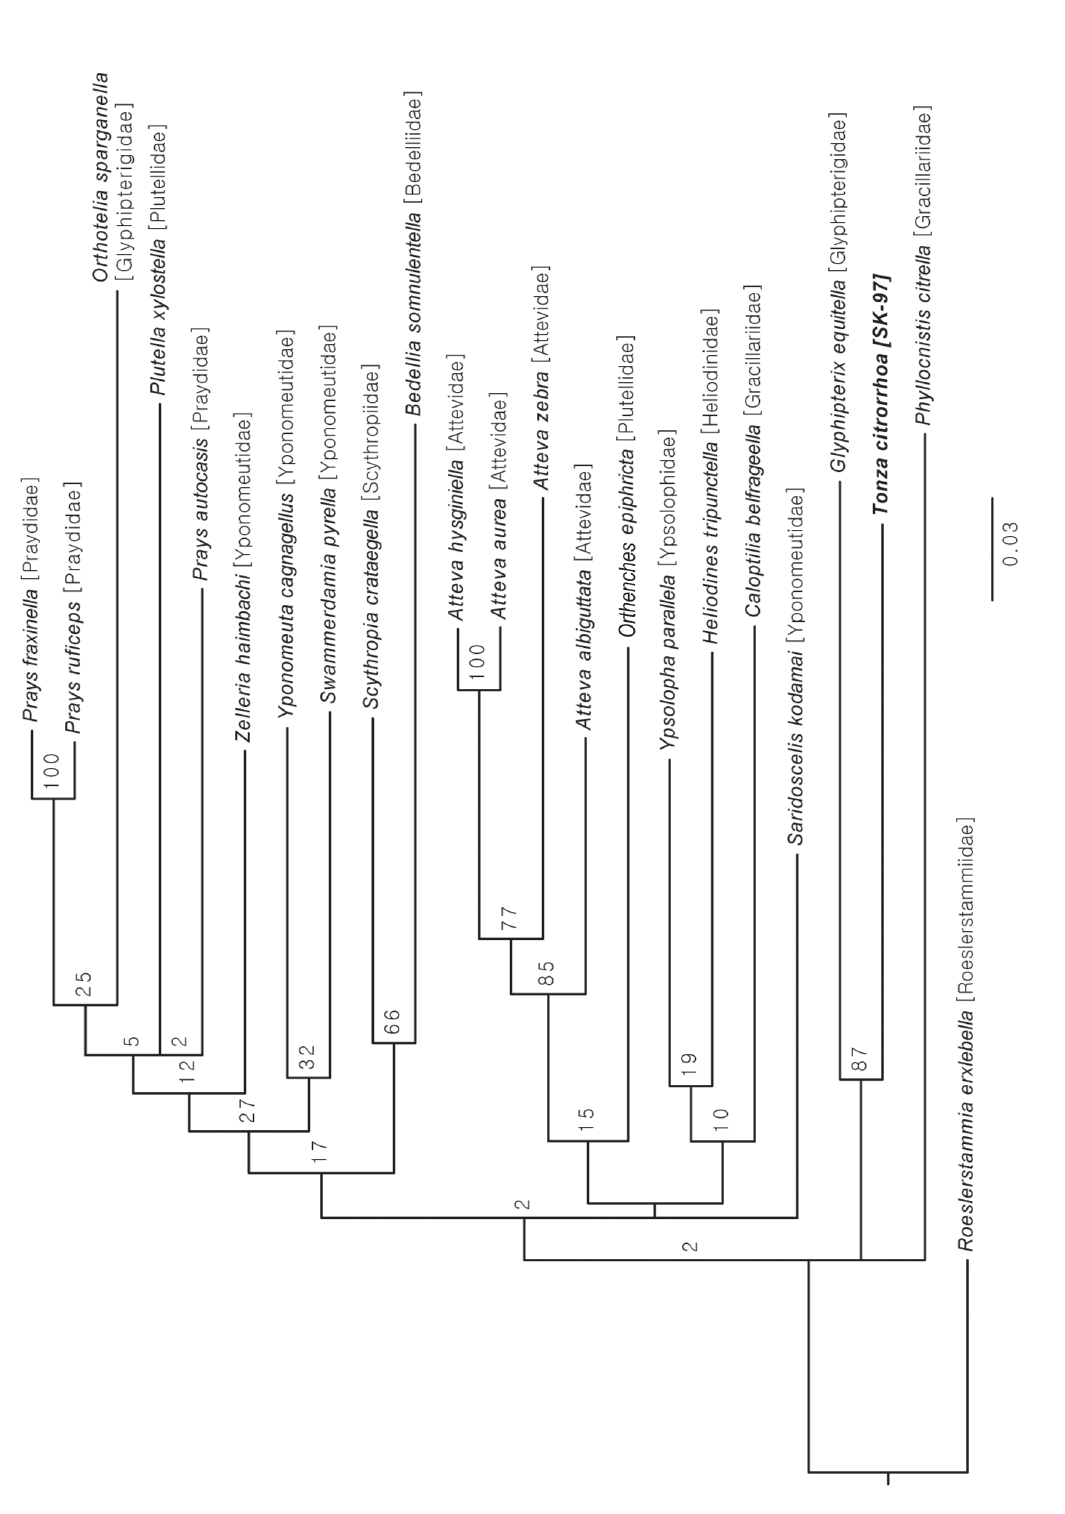
hoa rr o r it c a z on T s . e u a l uppo s